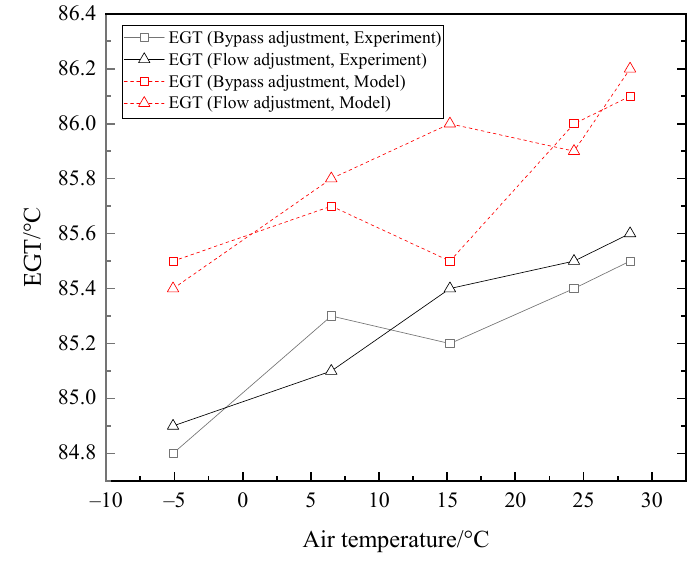
Figure 18. E h and E u as air temperature changed.